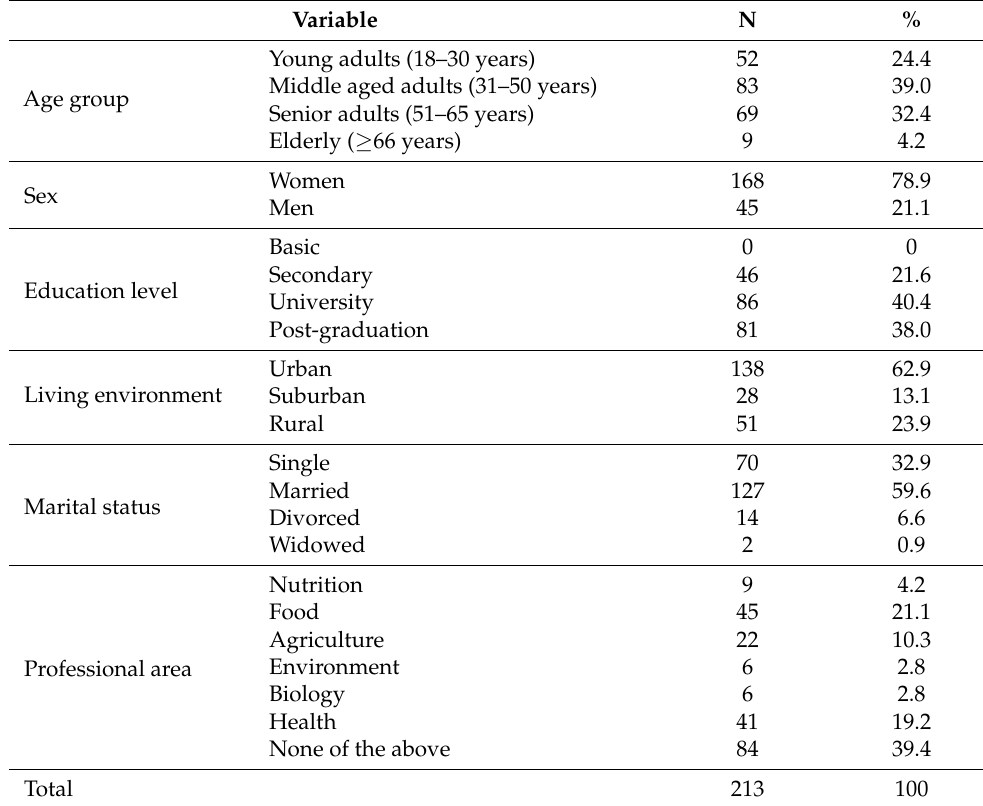
Table 2. Sociodemographic characterization of the sample at study.